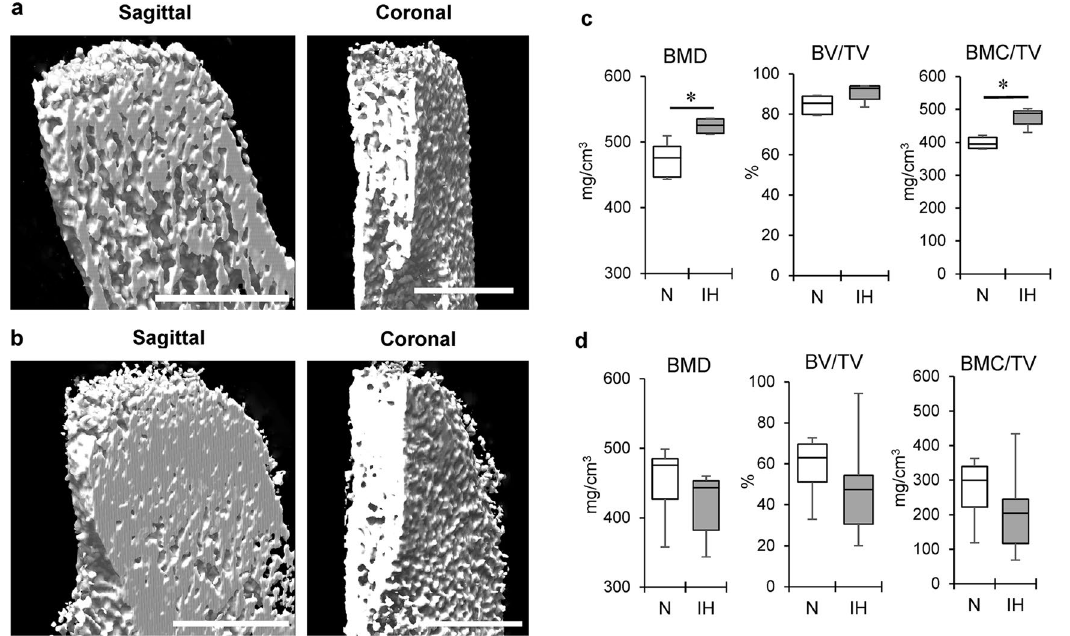
Figure 3. IH-induced high bone mineral density in mandibular condylar head in contrast to tibial epiphysis. Representative sagittal and coronal sections of mandibular condyle in the N ( a ) and IH ( b ) groups on 3D μCT imaging. Panel ( c ) shows comparative quantification of bone microstructural parameters in mandibular condyle cancelous bone between N and IH groups. Panel ( d ) shows comparisons of cancelous bone of proximal tibial epiphysis in both groups. BMD, bone mineral density; BV/TV, bone volume/trabecular volume; BMC/TV, bone mineral content/trabecular volume. Scale bar = 50 μm. Data are mean ± SEM for each group. * P <